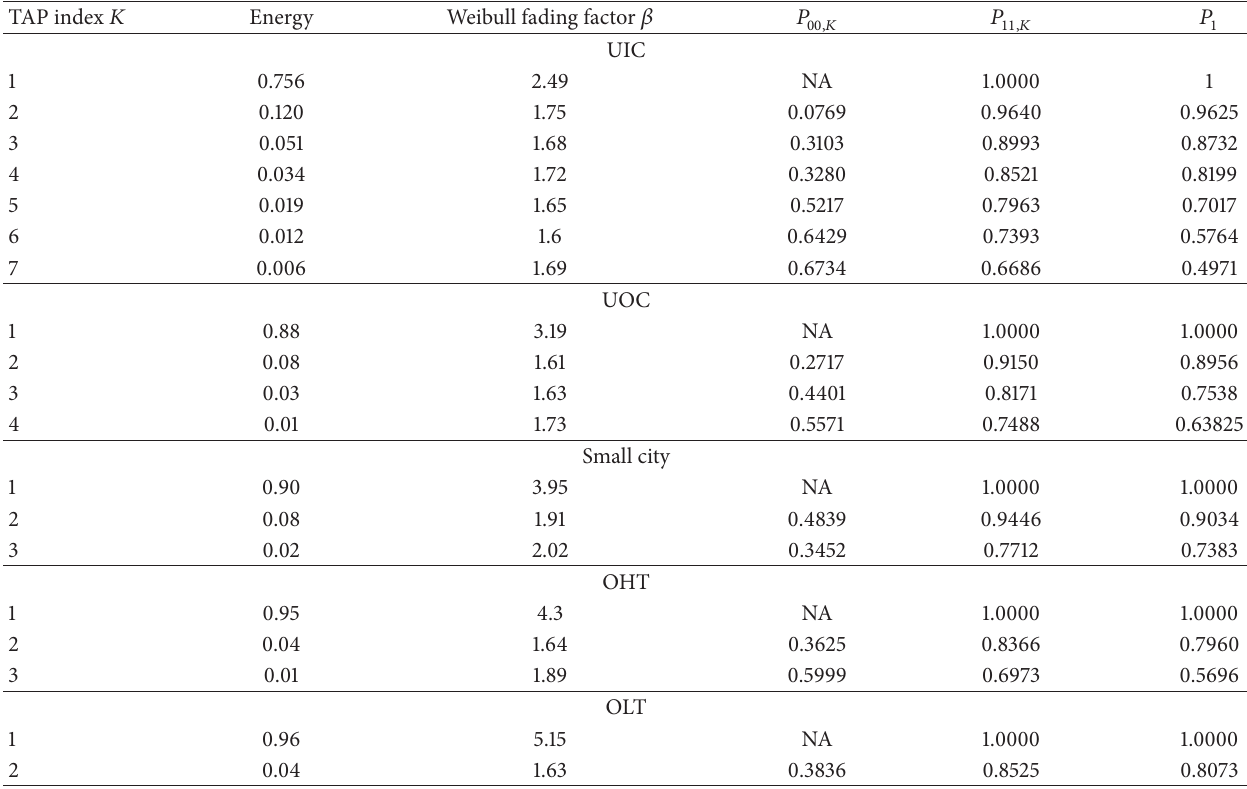
Table 1: Channel models parameters.